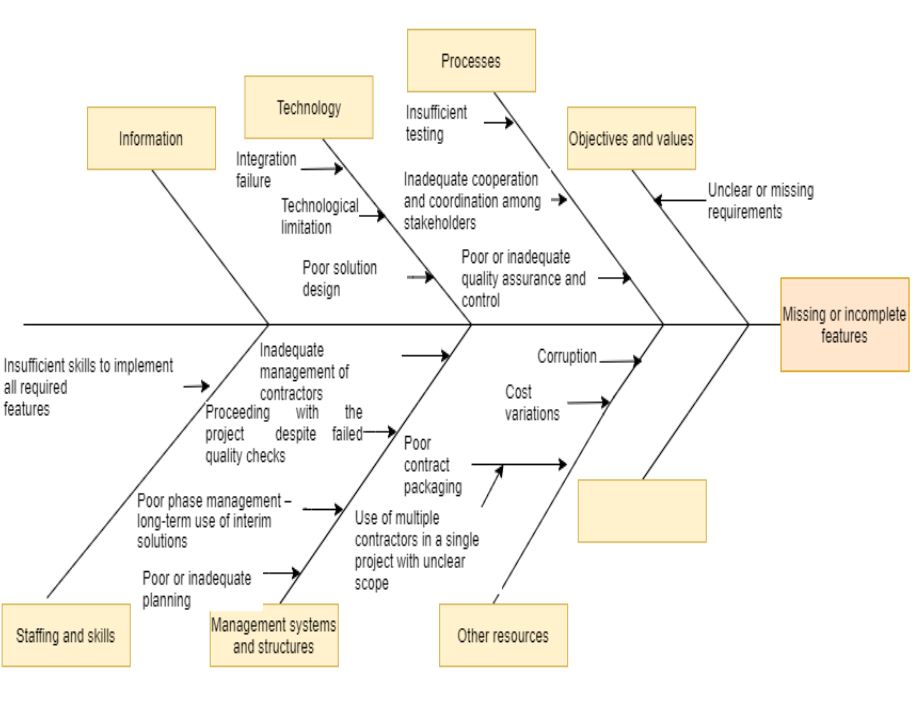
Figure 4: Missing or incomplete